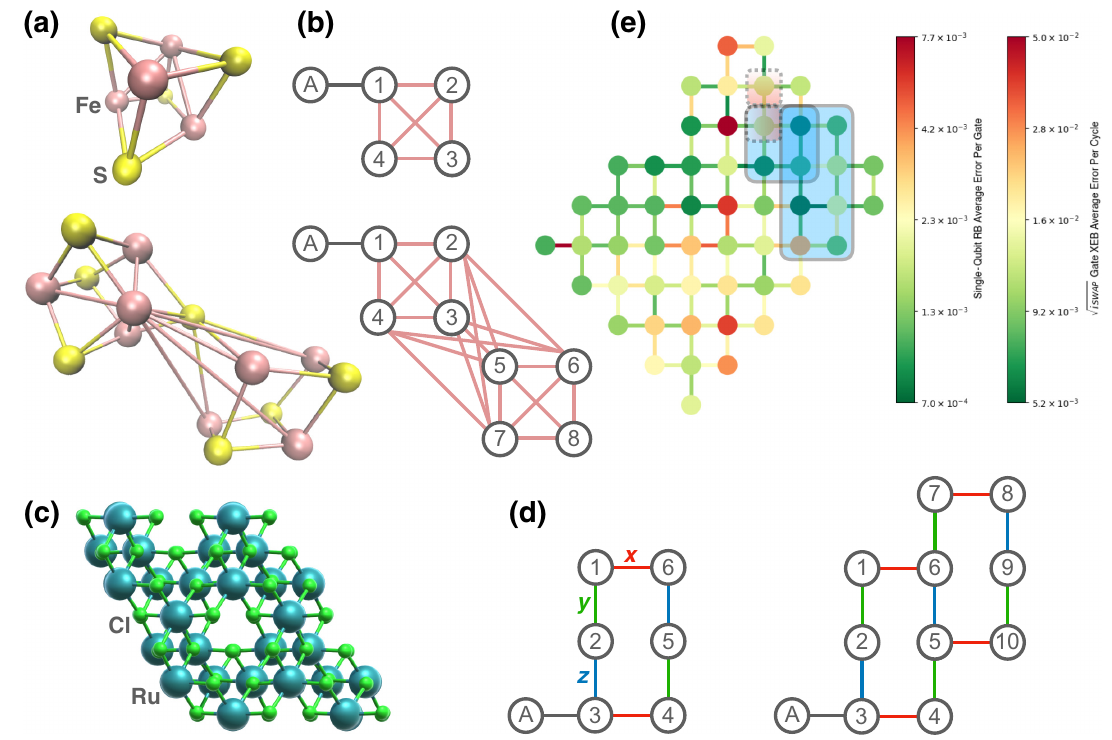
FIG. 1. (a) The molecular structures of the [4Fe-4S] and [8Fe-7S] P clusters. (b) The topology of the four-site and eight-site Heisen- berg spin models of the (top) [4Fe-4S] and (bottom) [8Fe-7S] P clusters. (c) The crystal structure of α -RuCl 3 : trigonal space group P3 1 12. (d) The topology of the six-site and ten-site Kitaev-Heisenberg spin models of α -RuCl 3 . The adjacent ancilla qubits are indi- cated as “A.” (e) Illustrative examples of qubit patches (blue) used for simulations of four-site and eight-site models. The ancilla qubits (dotted boxes) are shown in red. The color scheme of the qubits and connectivities represents the “single-qubit randomized √ i SWAP gate cross-entropy benchmarking (XEB) average error per cycle,” benchmarking (RB) average error per gate” and “two-qubit